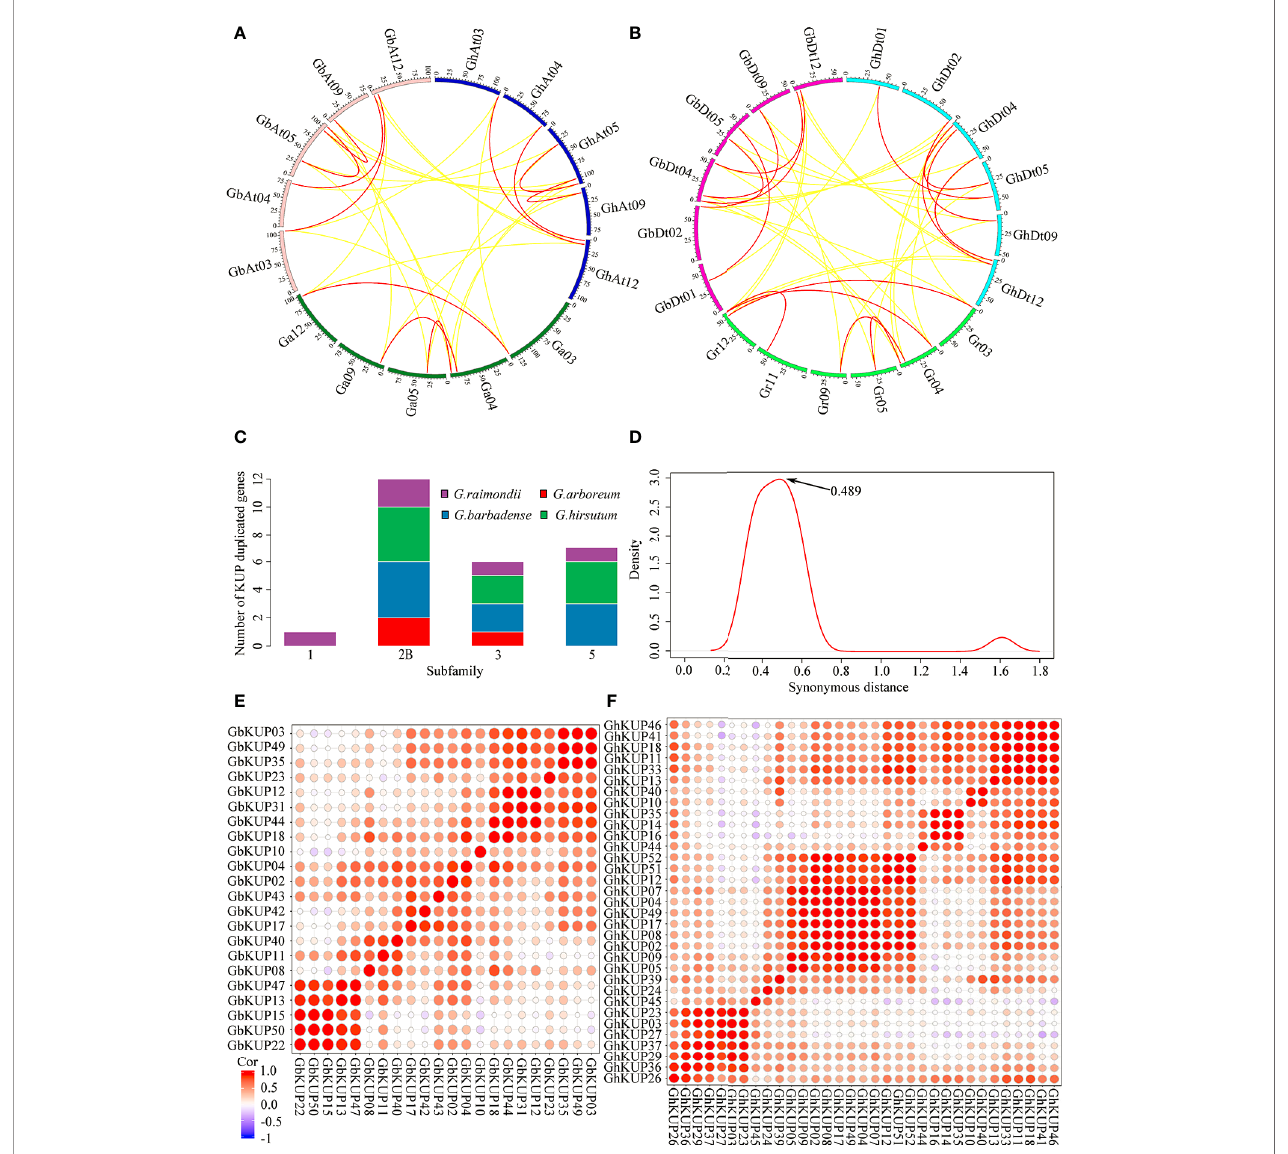
FIGURE 9 | Syntenic analysis, age distribution, and expression relationship of the duplicated KUP members in cotton. (A, B) Syntenic relationship of the duplicated GhKUP s and GbKUP s in the A-related genome (A) and D-related genome (B) . Red lines connect duplicated KUP s, and yellow lines connect orthologous genes in other species. The different colored sections of the circles indicate different genomes or subgenomes. (C) Subfamily distribution of the duplicated KUP members in cotton. (D) Age distribution of the duplicated KUP s in cotton based on Ks values. The peak value of the duplicated KUP s is marked with an arrow. (E, F) Heat map of the PCC of the expression pro fi les of the GbKUP (E) and GhKUP (F) ( Figure 1 ; Tables S3 , S4 ). The increase in the KUP members of